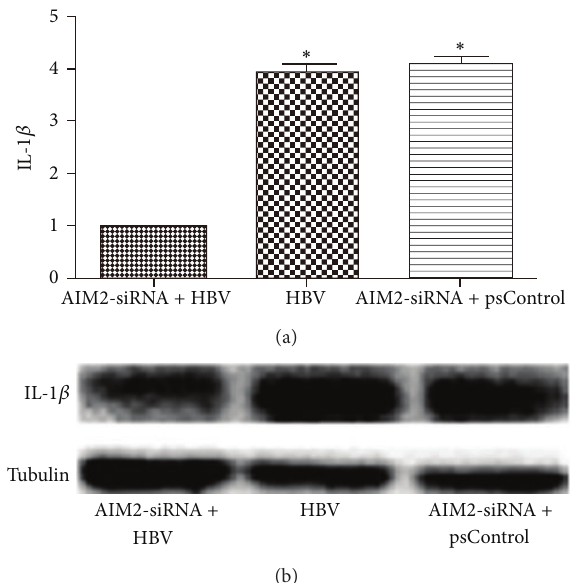
Figure 4: Down-regulation of AIM2 reduced expression of IL-1 𝛽 at the post-transcriptional level (a) and at the translational level (b). HGM cells were divided into three groups: AIM2-siRNA and HBV DNA co-transfected group (group A), HBV DNA-transfected group without AIM2-siRNA(group B) and AIM2-siRNAand empty plasmids co-transfected group (group C). The expression of IL-1 𝛽 in groupAdetectedbyqRT-PCRdecreasedin2.8,3.3foldsrespectively compared with group B and group C (a). These changes were also noted at the translational level, as measured by Western blot (b). ∗ indicates a significant difference compared with the control ( 𝑃 < 0.01 ). 𝑛 = 3 independent experiment RNA samples for each group.